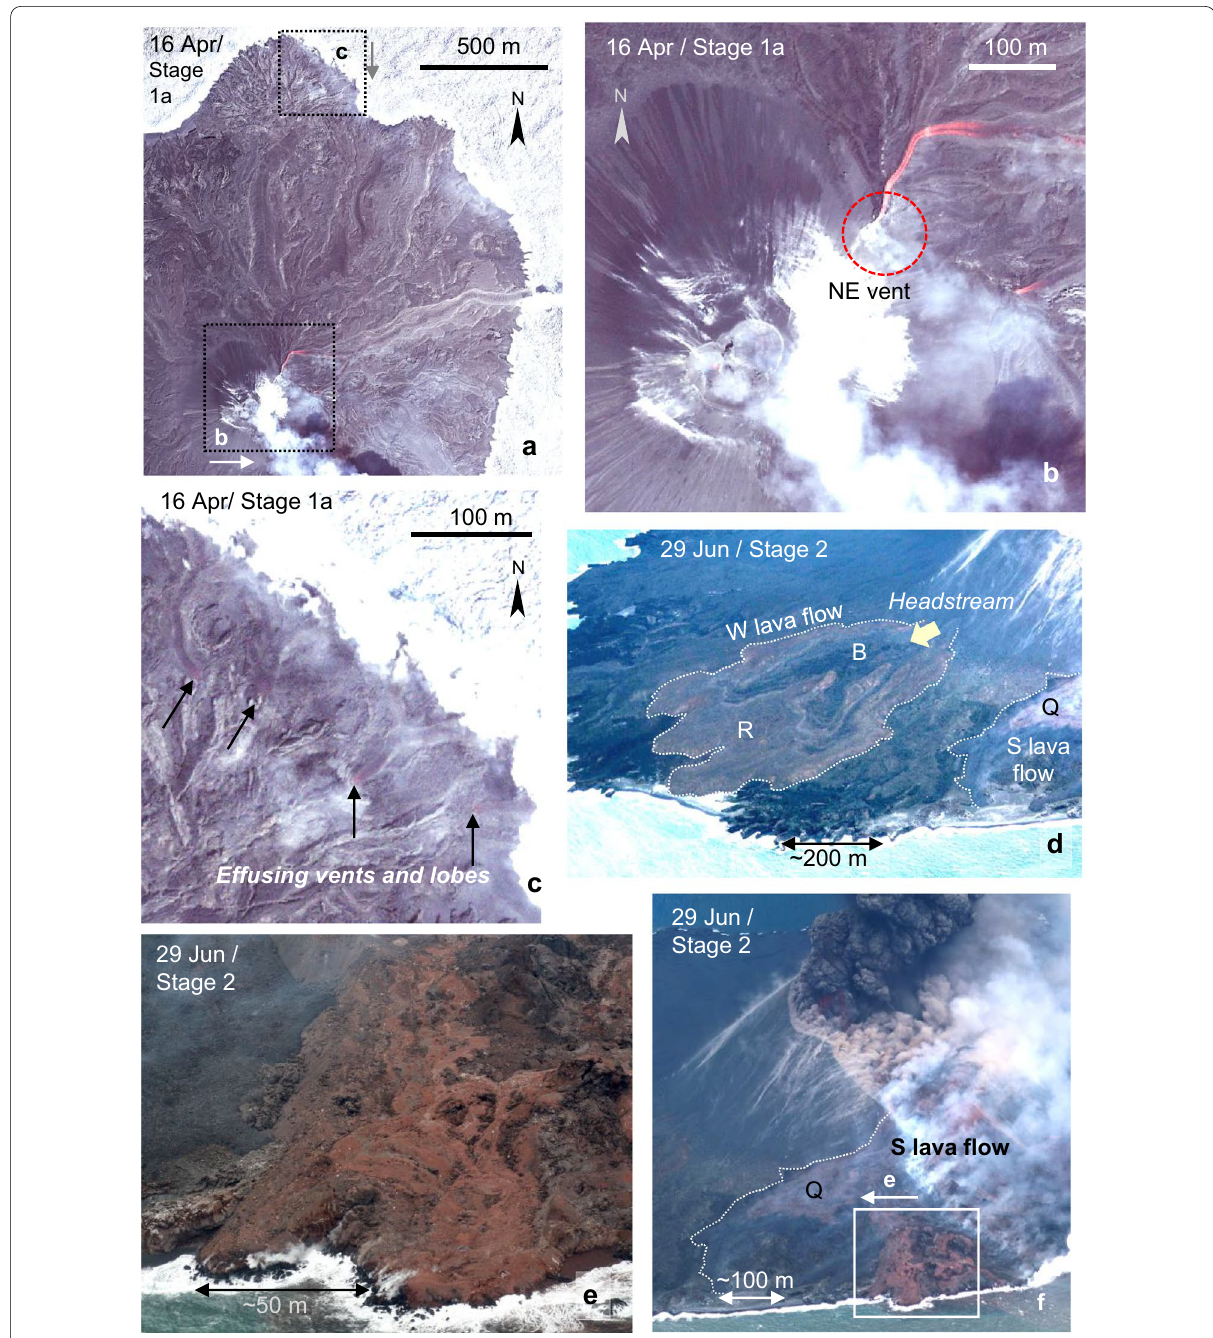
Fig. 5 High-resolution satellite images and aerial photographs of the Episode 4 activity of Nishinoshima. a Northeastern part of Nishinoshima taken on 16 April 2020 (WorldView-3). b Close-up of the northeastern part of the pyroclastic cone (the same image as a). c Close-up of part of the deltaic landform near the coast formed by small lava lobes (the same image as a). d Aerial photograph of the Western lava flow taken on 29 June by the Japan Coast Guard (Japan Coast Guard 2021); “Q” is the same point as in f. e Close-up of the flow front of the Southern lava flow taken on 29 June by the Japan Coast Guard (Japan Coast Guard 2021). f Southwestern slope of the pyroclastic cone photographed on 29 June by the Japan Coast Guard (Japan Coast Guard 2021). g Main part of the Southern lava flow and the pyroclastic cone imaged on 3 July 2020 (ALOS-2). h The same area as g and i on 17 July 2020 (ALOS-2). i The same area as g and h on 31 July 2020 (ALOS-2). j Flow front of the Southern lava flow imaged on 19 July (WorldView-3). Many large blocks can be recognized on the surface. k Lava fountain observed from a JMA observation vessel on 11 July (imaged by JMA). l Release of fine ash resulting from the phreatomagmatic eruption (imaged on 30 July by SN). m Wide-spread ash plume released by the phreatomagmatic eruptions of Stage 3 observed by Himawari-8 on 2 August 2020 (NICT